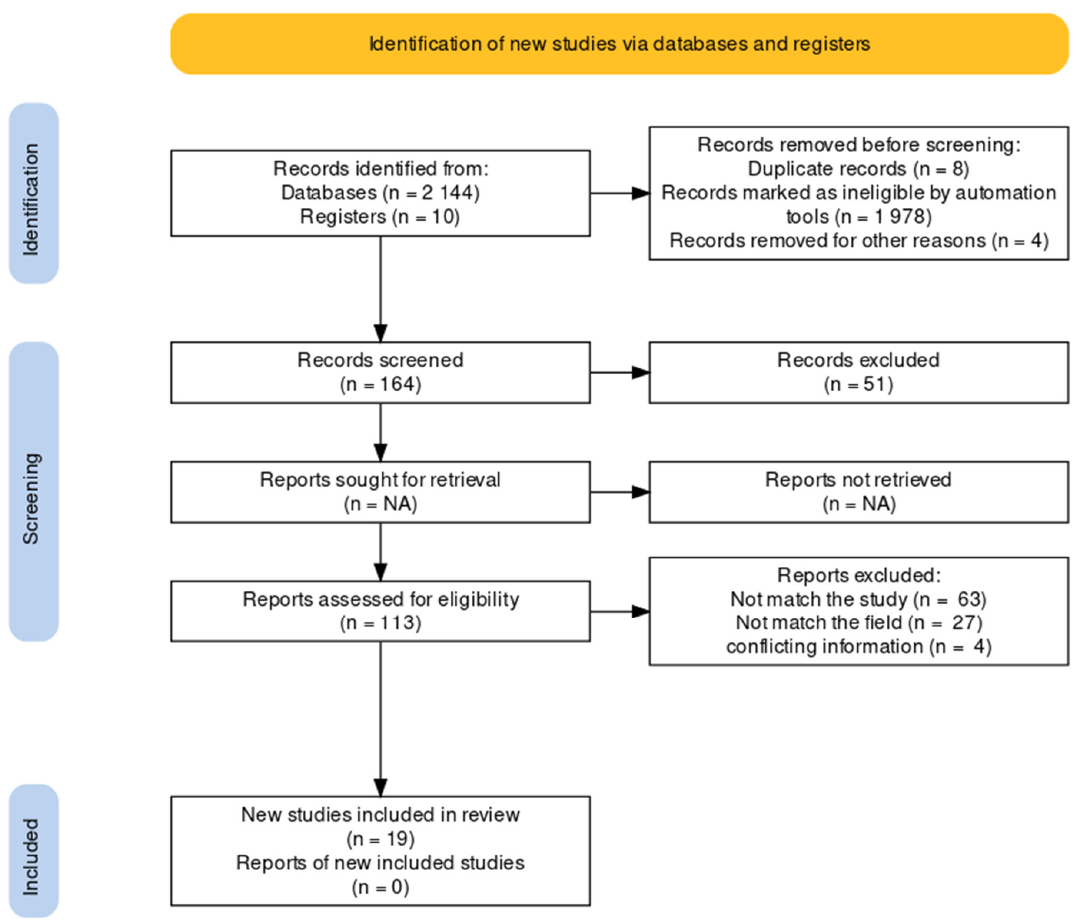
Scheme 1. PRISMA flow chart for a review energy efficiency, Industry 4.0 and wood Industry.